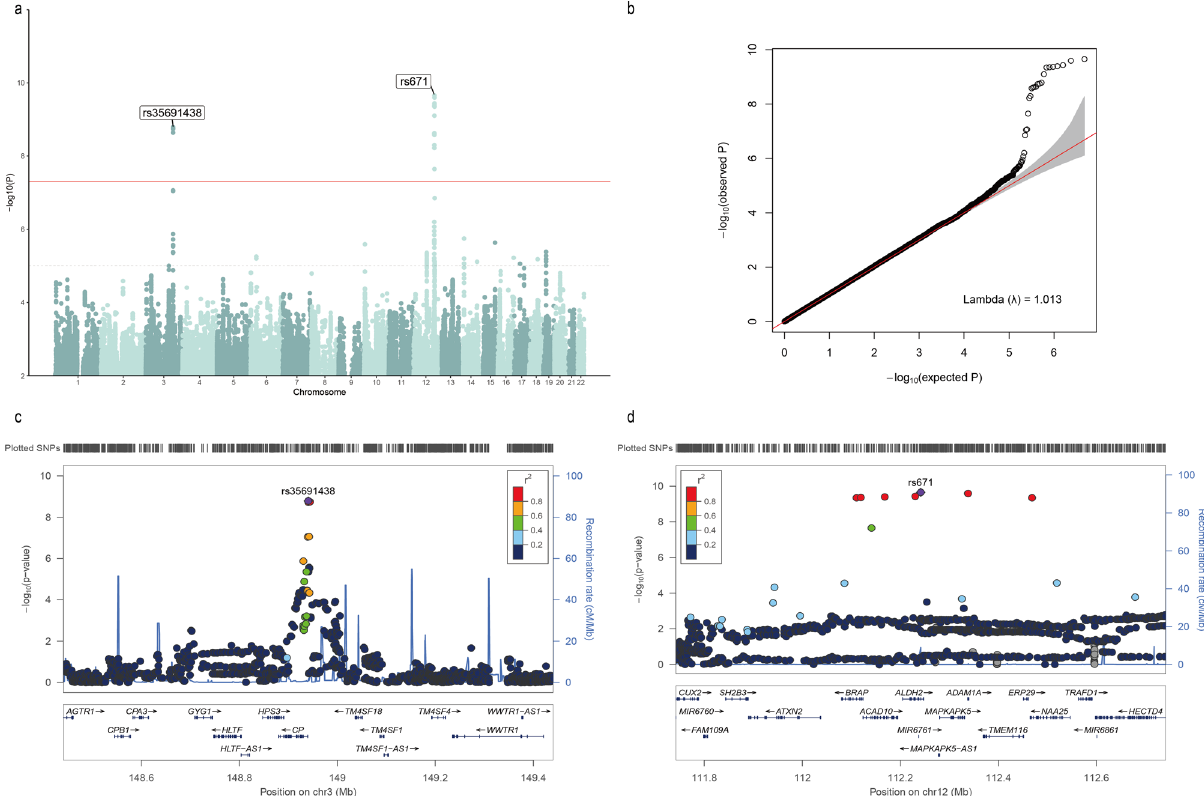
Fig. 1 The Manhattan, Quantile-Quantile, and LocusZoom plots of GWAS meta-analysis of serum copper levels. a Manhattan plot. The X -axis presents the genomic position, while the Y -axis presents the − log 10 ( P ) of SNPs. The solid red line is the genome-wide signi fi cance threshold ( P = 5.0 × 10 − 8 ), and the black dashed line is the genome-wide suggestive threshold ( P = 1.0 × 10 − 5 ). b The Quantile-Quantile plot shows the deviation of the observed from the expected P -values under the null hypothesis of no association. c LocusZoom plot for gene CP . Purple diamond indicates SNP at the locus with the strongest association evidence (rs35691438) and the r 2 (degree of linkage disequilibrium) is 1. Each point represents one SNP. d LocusZoom plot for gene ALDH2 . Purple diamond indicates SNP at the locus with the strongest association evidence (rs671) and the r 2 (degree of linkage disequilibrium) is